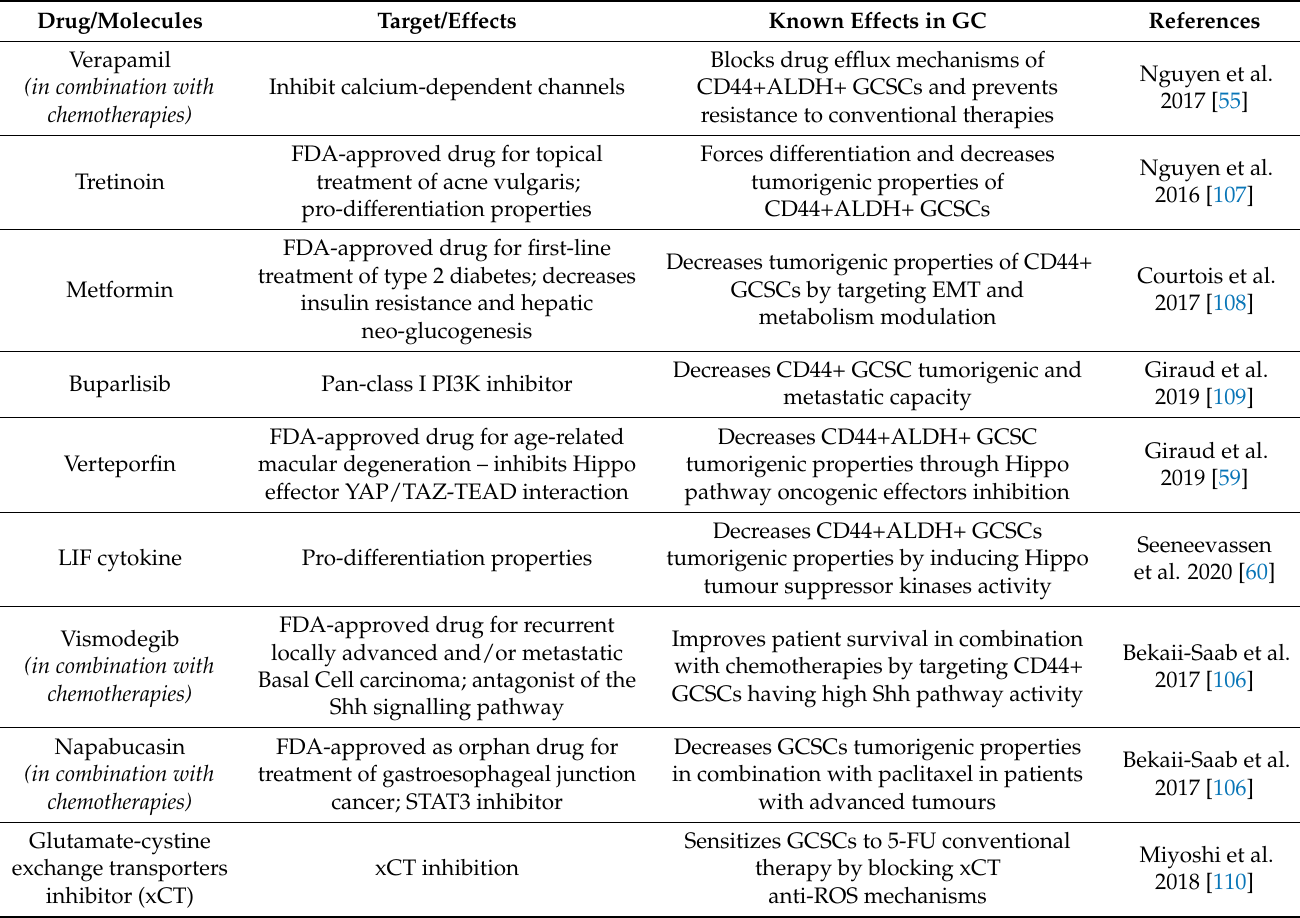
Table 2. Summary of potential Drug and/or Molecules for the targeting of